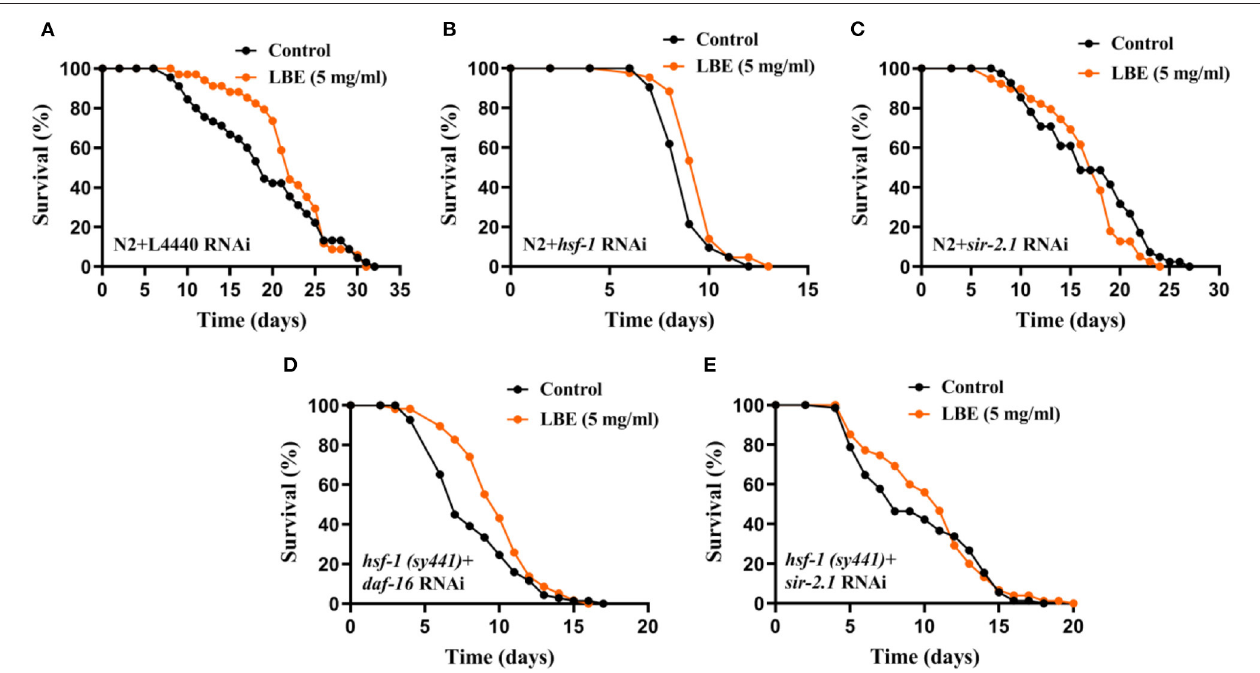
FIGURE 6 | LBE rescues hsf-1 deficiency depending on sir-2.1 . (A) Lifespan analysis of N2 worms fed with empty vector L4440 RNAi bacteria treated with vehicle or 5 mg/ml LBE at 20 ◦ C (control: n = 45, mean lifespan 19.2 days; 5 mg/ml LBE: n = 34, mean lifespan 22.2 days; p = 0.256). (B) Lifespan analysis of N2 worms fed with hsf-1 RNAi bacteria treated with vehicle or 5 mg/ml LBE at 20 ◦ C (control: n = 42, mean lifespan 8.9 days; 5 mg/ml LBE: n = 43, mean lifespan 9.6 days; p = 0.005). (C) Lifespan analysis of N2 worms fed with sir-2.1 RNAi bacteria treated with vehicle or 5 mg/ml LBE at 20 ◦ C (control: n = 41, mean lifespan 17.0 days; 5 mg/ml LBE: n = 39, mean lifespan 16.6 days; p = 0.172). (D) Lifespan analysis of hsf-1 (sy441) worms fed with daf-16 RNAi bacteria treated with vehicle or 5 mg/ml LBE at 20 ◦ C (control: n = 69, mean lifespan 8.3 days; 5 mg/ml LBE: n = 58, mean lifespan 9.9 days; p = 0.018). (E) Lifespan analysis of hsf-1 (sy441) worms fed with sir -2.1 RNAi bacteria treated with vehicle or 5 mg/ml LBE at 20 ◦ C (control: n = 71, mean lifespan 9.6 days; 5 mg/ml LBE: n = 75, mean lifespan 10.6 days; p = 0.470). For all lifespan analysis, FUdR at 30 µ M was supplemented to prevent progeny production. All the results are representative of at least two independent lifespan experiments. Log-rank test was used to assess significance (see also Supplementary Table 6 ). LBE, total water extracts of L. barbarum